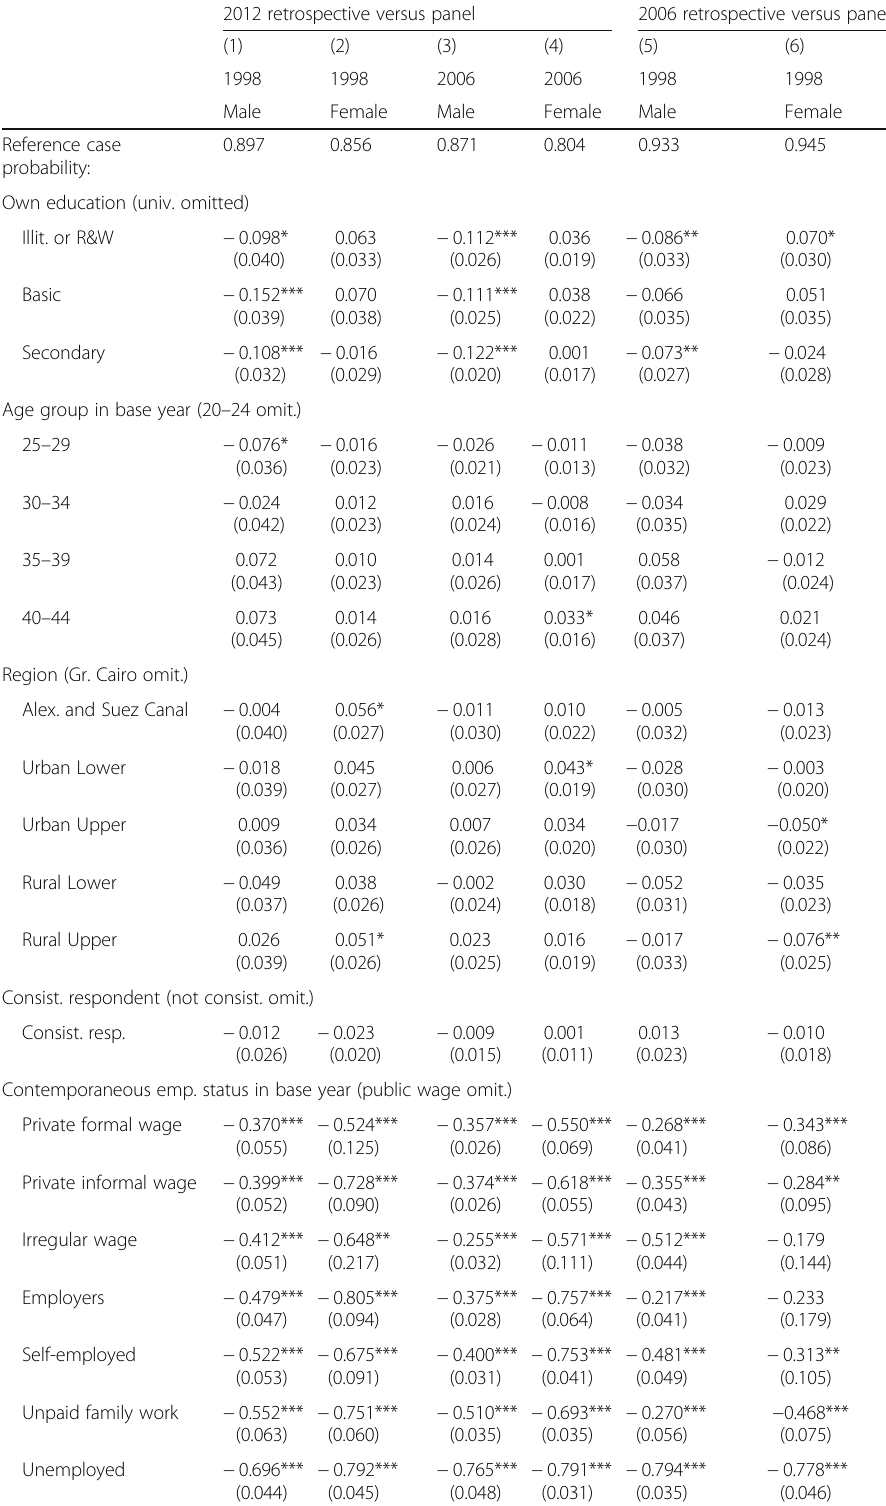
Table 3 Probit model marginal effects for the probability of alignment of labor market status between contemporaneous 1998 or 2006 and 2012 or 2006 retrospective data by sex, individuals in base year (1998 or 2006) and present in the other waves, aged 20 – 44 in base year of the